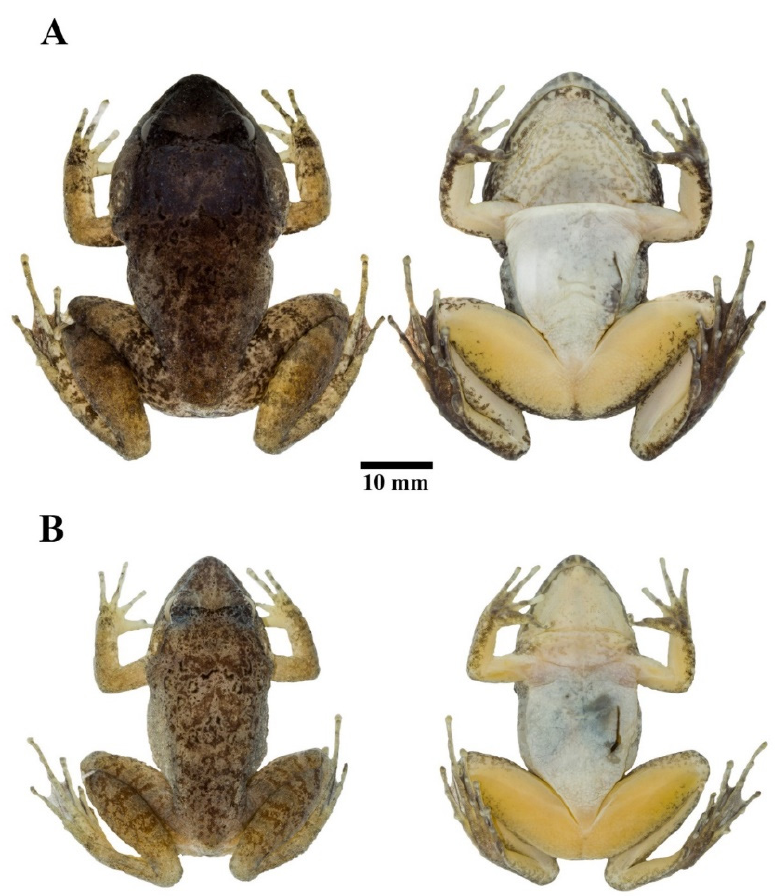
Figure 6. Sexual dimorphism of Limnonectes pseudodoriae sp. nov . in preservative. Dorsal (left) and ventral (right) views of ( A ) holotype male (ZMKU AM 01567), and ( B ) paratype female (ZMKU AM 01573).